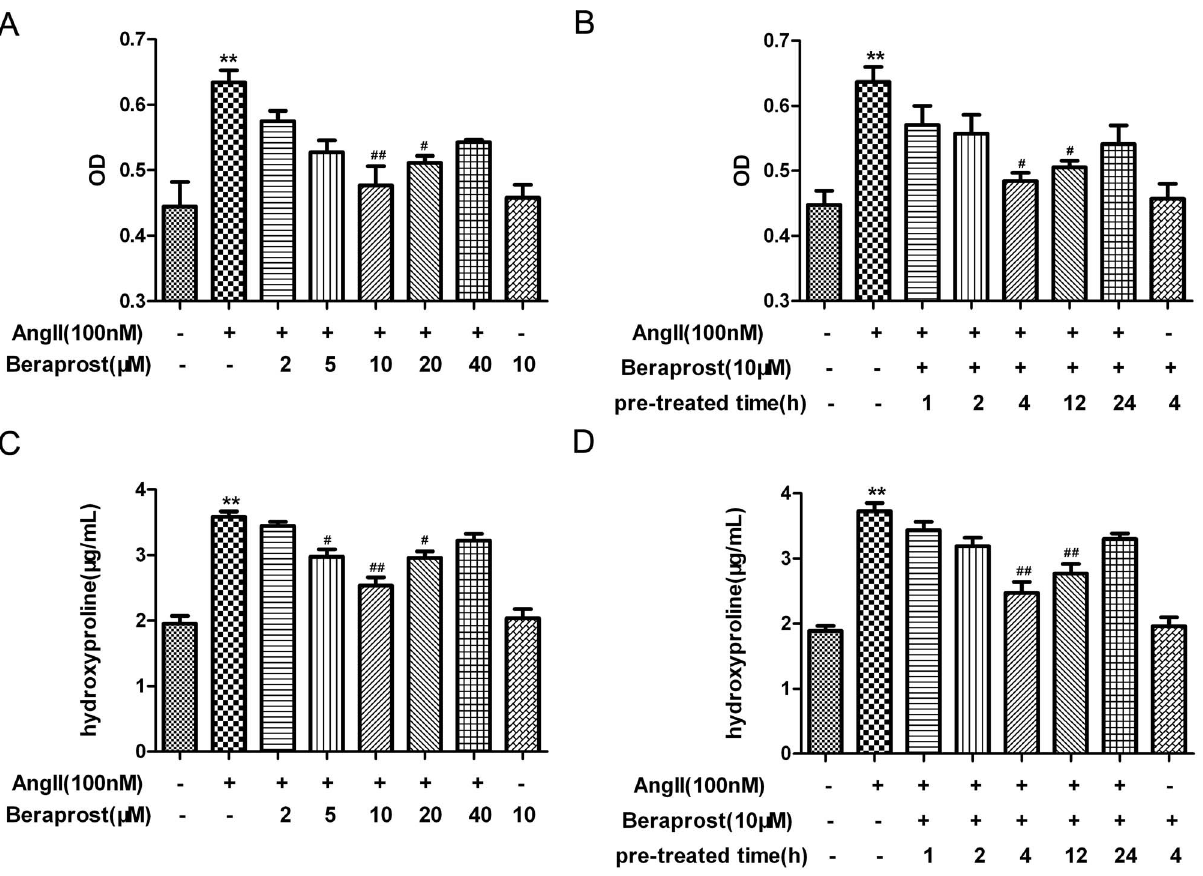
Figure 1. Beraprost inhibited Ang II-induced cardiac fibroblasts proliferation. (A) Neonatal rat cardiac fibroblasts were pre-treated with different concentrations of beraprost for 4 h followed by Ang II (100 nM) stimulation for an additional 24 h. The number of cells was represented as an OD value using a cell count assay. (B) Content of hydroxyproline in cell culture medium was determined. (C) Neonatal rat cardiac fibroblasts were pre-treated with beraprost (10 m M) for different times followed by Ang II (100 nM) stimulation for an additional 24 h. The number of cells was represented as an OD value. (D) Content of hydroxyproline in cell culture medium was determined. Values are expressed as mean 6 SEM. Cells treated with culture medium served as a vehicle control (con). ** P , 0.01, compared with con, # P , 0.05, ## P , 0.01 compared with only Ang II stimulated group. n=4–5.